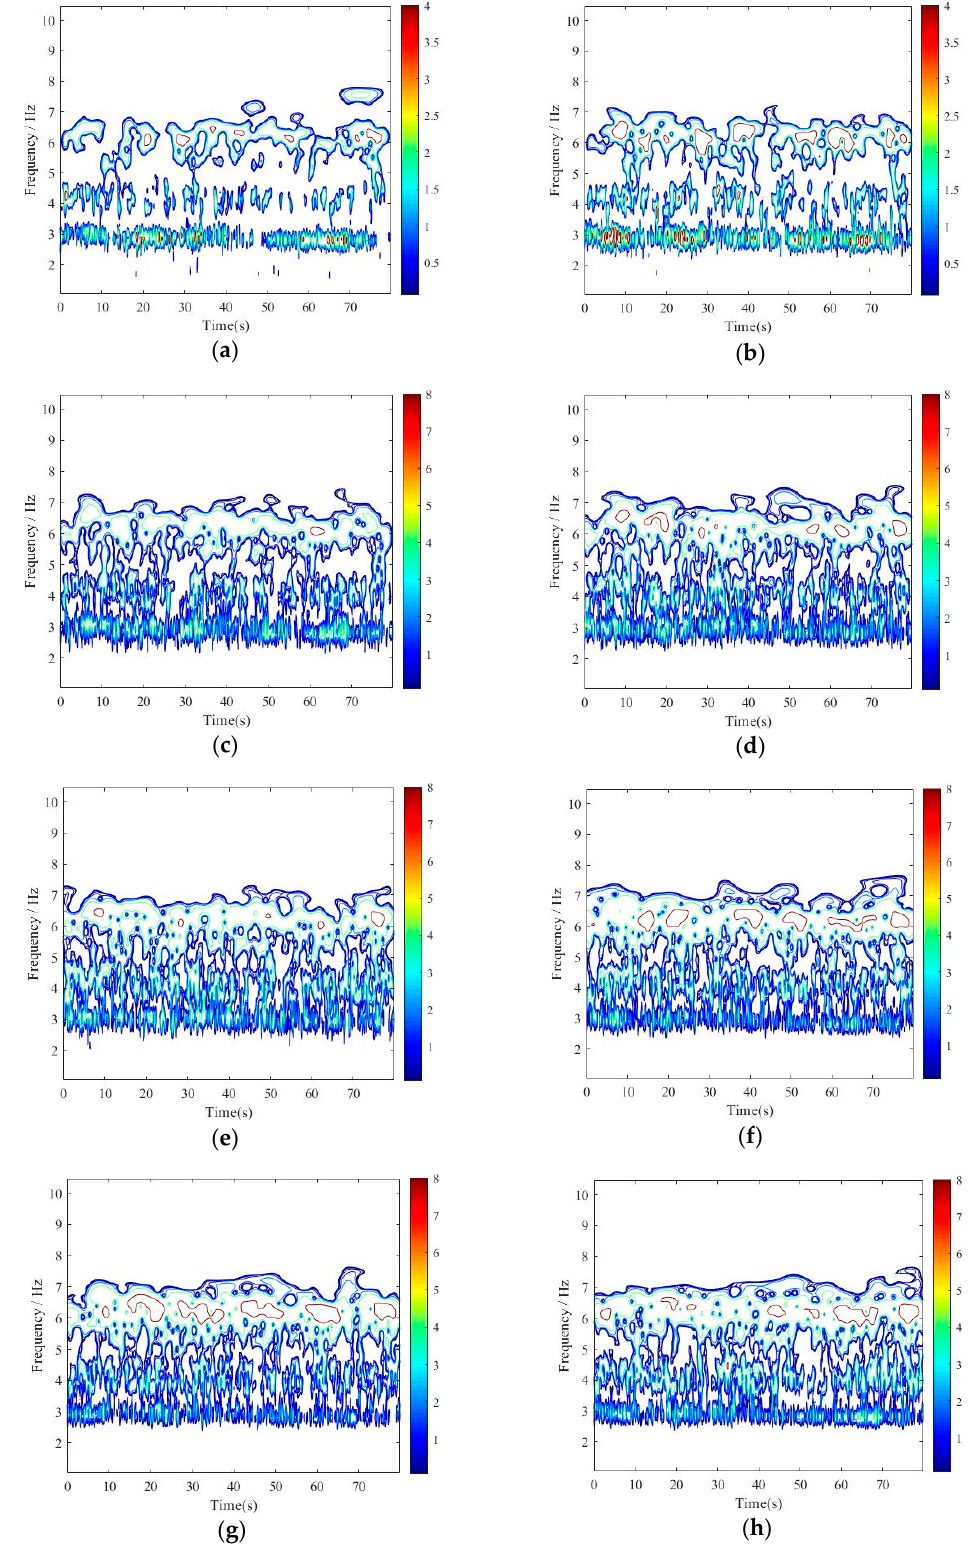
Figure 18. Contour of the cross-wavelet scalogram (XWS) between 1# dam block and corresponding guide wall blocks. ( a ) 1# guide wall block; ( b ) 2# guide wall block; ( c ) 3# guide wall block; ( d ) 4# guide wall block; ( e ) 5# guide wall block; ( f ) 6# guide wall block; ( g ) 7# guide wall block; ( h ) 8# guide wall block.